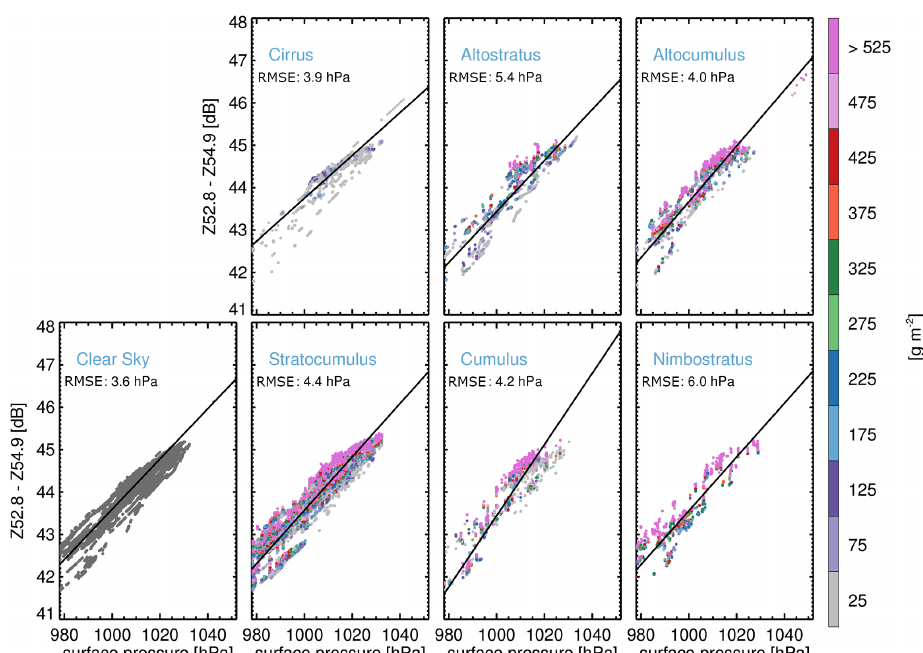
Figure 4. Simulated relationships between surface radar returns and surface pressure. Each point represents a CloudSat-driven simulation for each of the CloudSat measurements available in 15 January 2007 (clear-sky and cloudy cases only). The total hydrometeor column (for these cases IWC + LWC only) is color-coded. Dark gray is used for clear-sky cases (total hydrometeor column equal to zero). The root-mean-square error (RMSE) displayed is the overall linear regression error (black line) when fitting all the cases for each scenario.